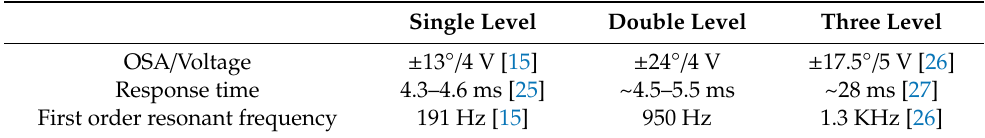
Table 1. Comparison of the main mechanical properties between three MEMS mirrors deploying Al /